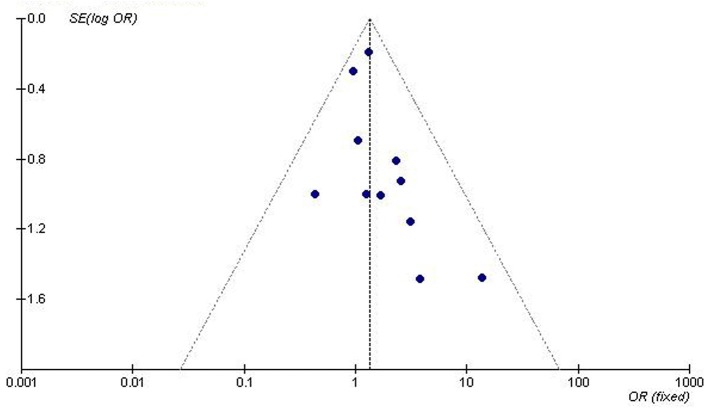
Funnel plot for studies of the association of T2DM associated with GHRL gene Leu72Met (L72M) polymorphism under a recessive genetic model (LM+MM vs. LL). The dot distribution in the funnel plot is symmetrical which imply no publication bias is present in the current meta-analysis by using the recessive genetic model. The horizontal and vertical axis correspond to the OR and confidence limits. OR, odds ratio; SE, standard error.